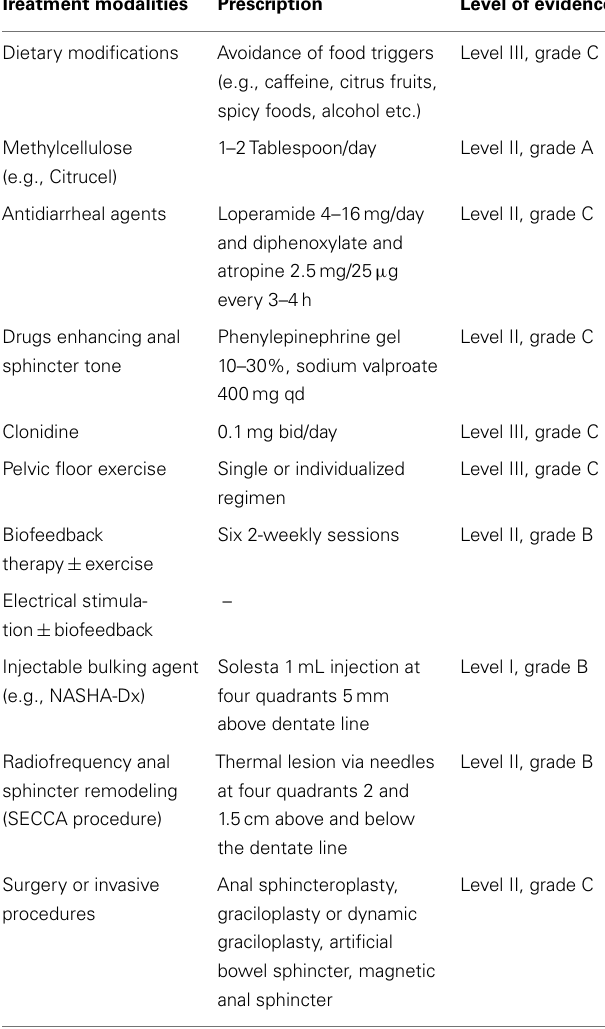
Table 2 | Evidence-based management of fecal